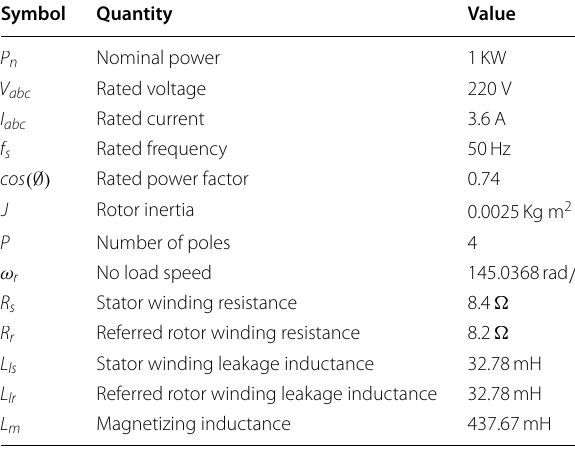
Table 3 Specification of IM